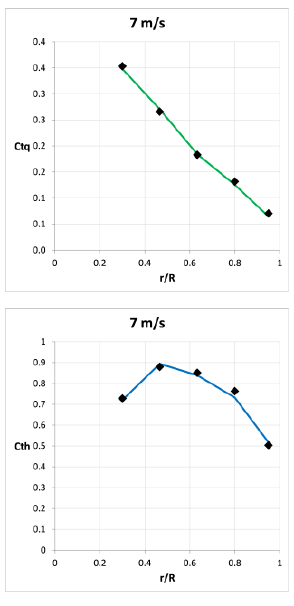
Figure 12. Blade spanwise distributions of torque coefficients (first row, C tq ) and thrust coefficients (second row, C th ) vs. data derived from measurements at four representative wind velocities. Exper- imental data is represented as black squares and numerical data is drawn as green ( C tq ) and blue ( C th ) curves.